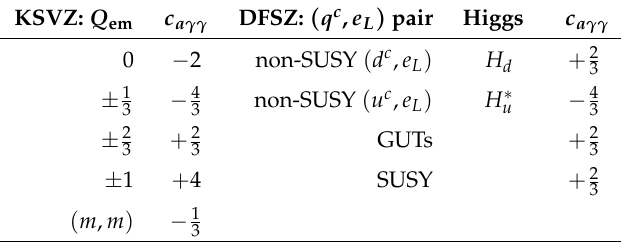
Table 1. The coupling c a γγ for c 0 a γγ = ˜ c a γγ given in the KSVZ and DFSZ models. For the u and d quark masses, m u = 0.5 m d is assumed for simplicity. ( m , m ) in the last row of KSVZ means m quarks of 1 Q em = 2 e and m quarks of Q em = e . SUSY in the DFSZ models includes contributions of color 3 3 − partners of Higgsinos. If we do not include the color partners, i.e., in the MSSM without heavy colored particles, c a γγ 0. (cid:39) KSVZ: Q em c a γγ DFSZ: ( q c , e L ) pair Higgs c a γγ 0 2 −